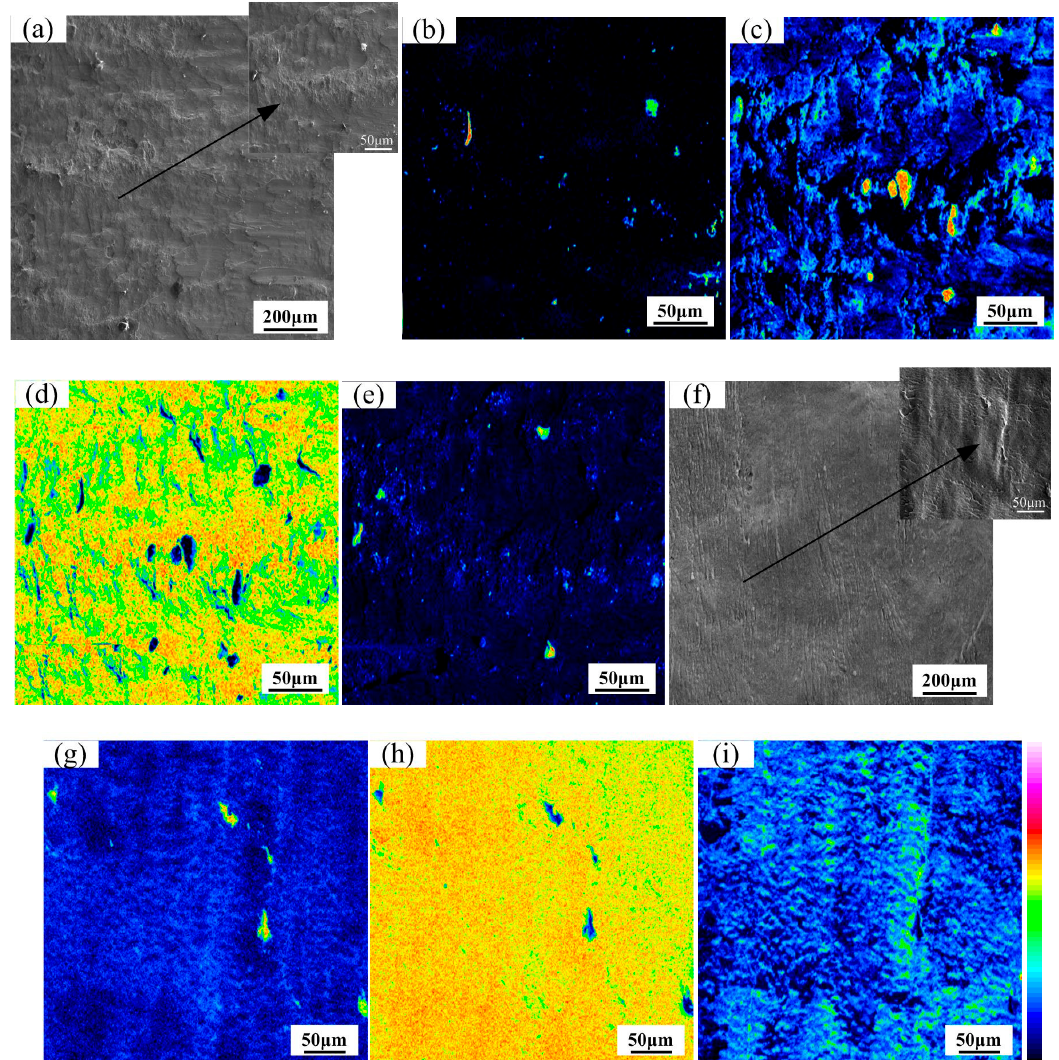
Figure 8. Map distribution micrographs of various elements on the fractural surface at 800 °C (Ti side): ( a ) BSE image; ( b ) Fe element; ( c ) Ti element; ( d ) Nb element and ( e ) C element for Ti/Nb/steel clad plate; ( f ) BSE image; ( g ) Fe element; ( h ) Ti element and ( i ) C element for Ti/steel clad plate.